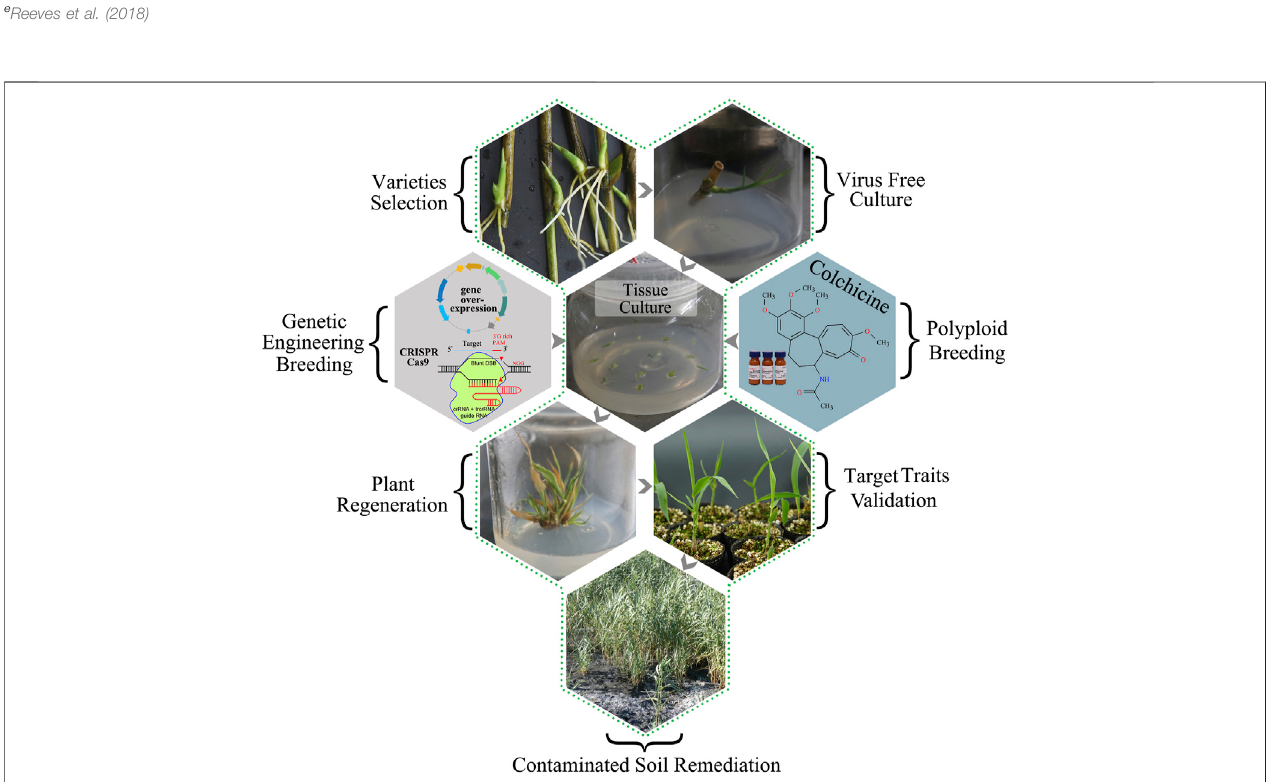
FIGURE 4 | Flow chart of breeding giant reed resistant varieties using transgenic